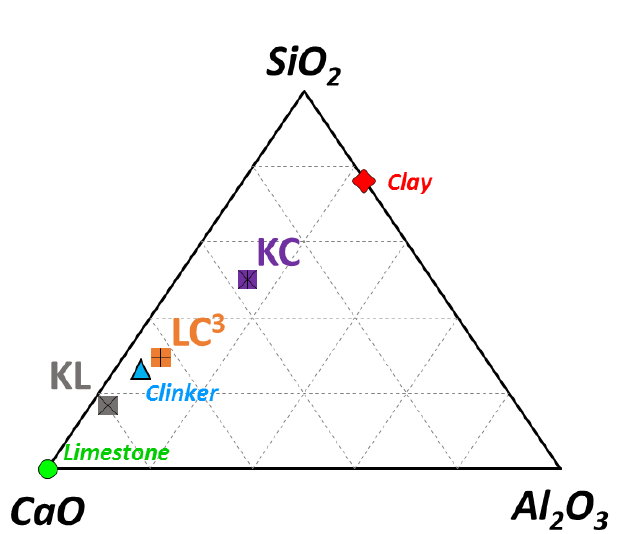
Figure 1. CaO-SiO 2 -Al 2 O 3 ternary diagram displaying the chemical composition of raw and mixed materials (wt %).